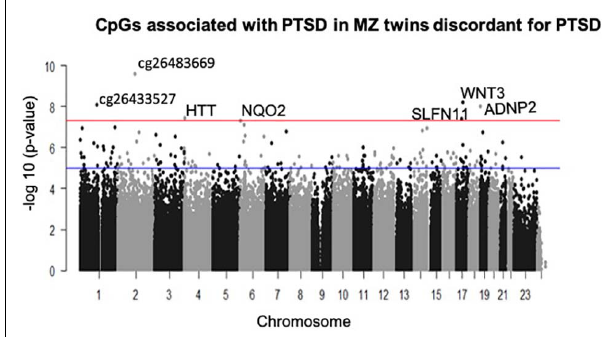
FIGURE 2 | Manhattan plot of CpGs associated with PTSD: the blue line indicates Bonferroni threshold of significance ( < 5.77 × 10 - 8 ) and the red line indicates 10% FDR. A total of 7 CpGs were significant at Bonferroni threshold and 1,585 CpGs were significant at 10% FDR.